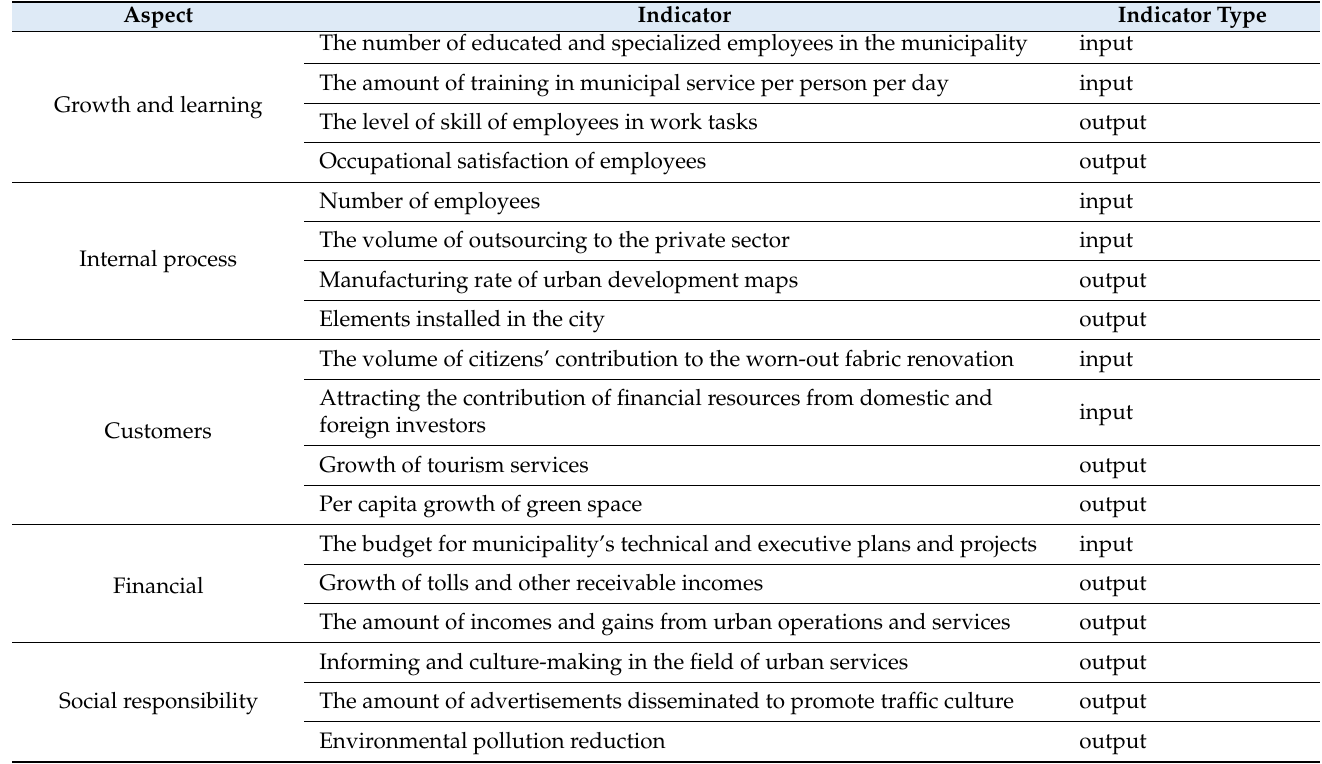
Table 2. Selected indicators for measuring the effectiveness of the evaluated units. Indicator Indicator